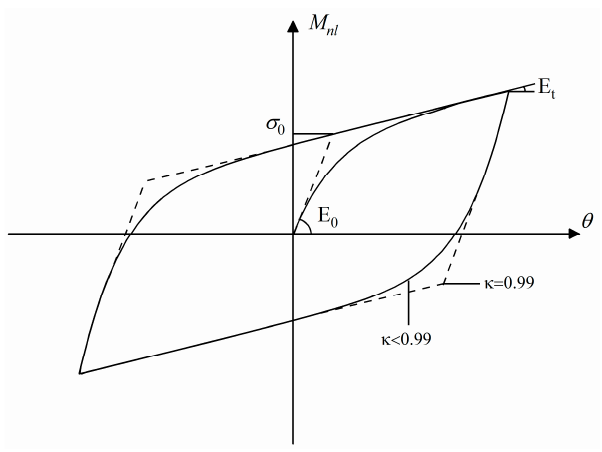
Figure 4. A typical hysteresis loop of the Valanis model.